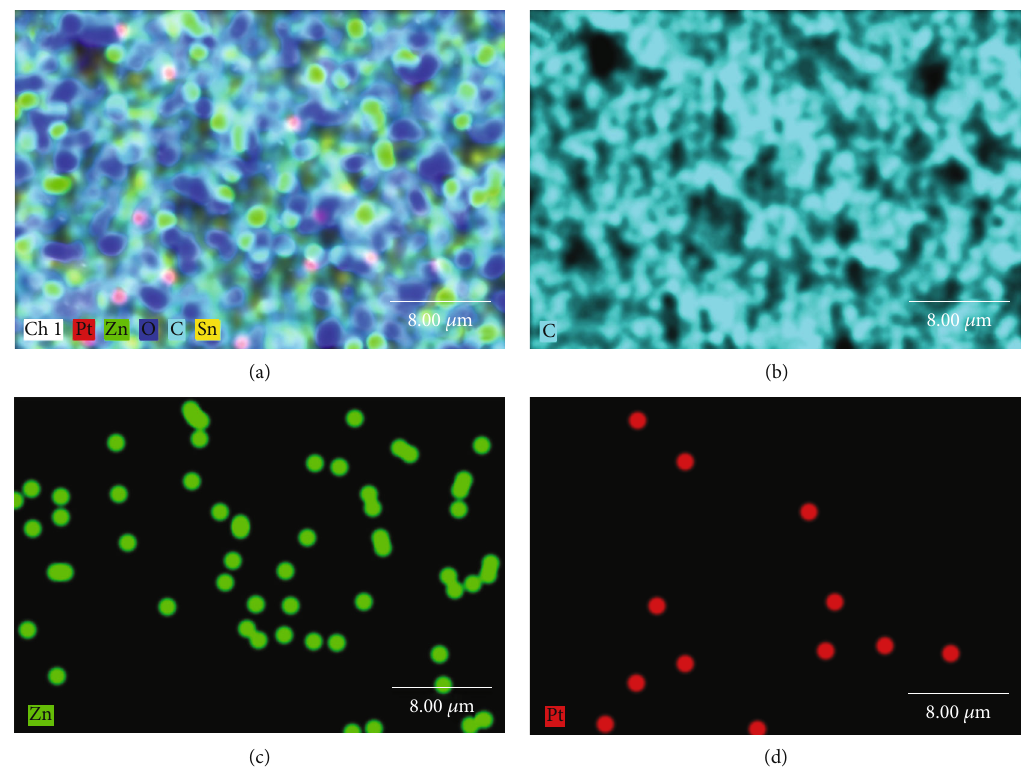
Figure 4: Elemental mapping of the Diazocine fi lm/ZnO NR/Pt NP hybrid showing (a) distribution of the Zn, O, C, Sn and Pt elements throughout the given area; (b) organic C element distribution showing the uniformity of organic fi lm coverage; (c) Zn elemental distribution and (d) cocatalyst Pt NP